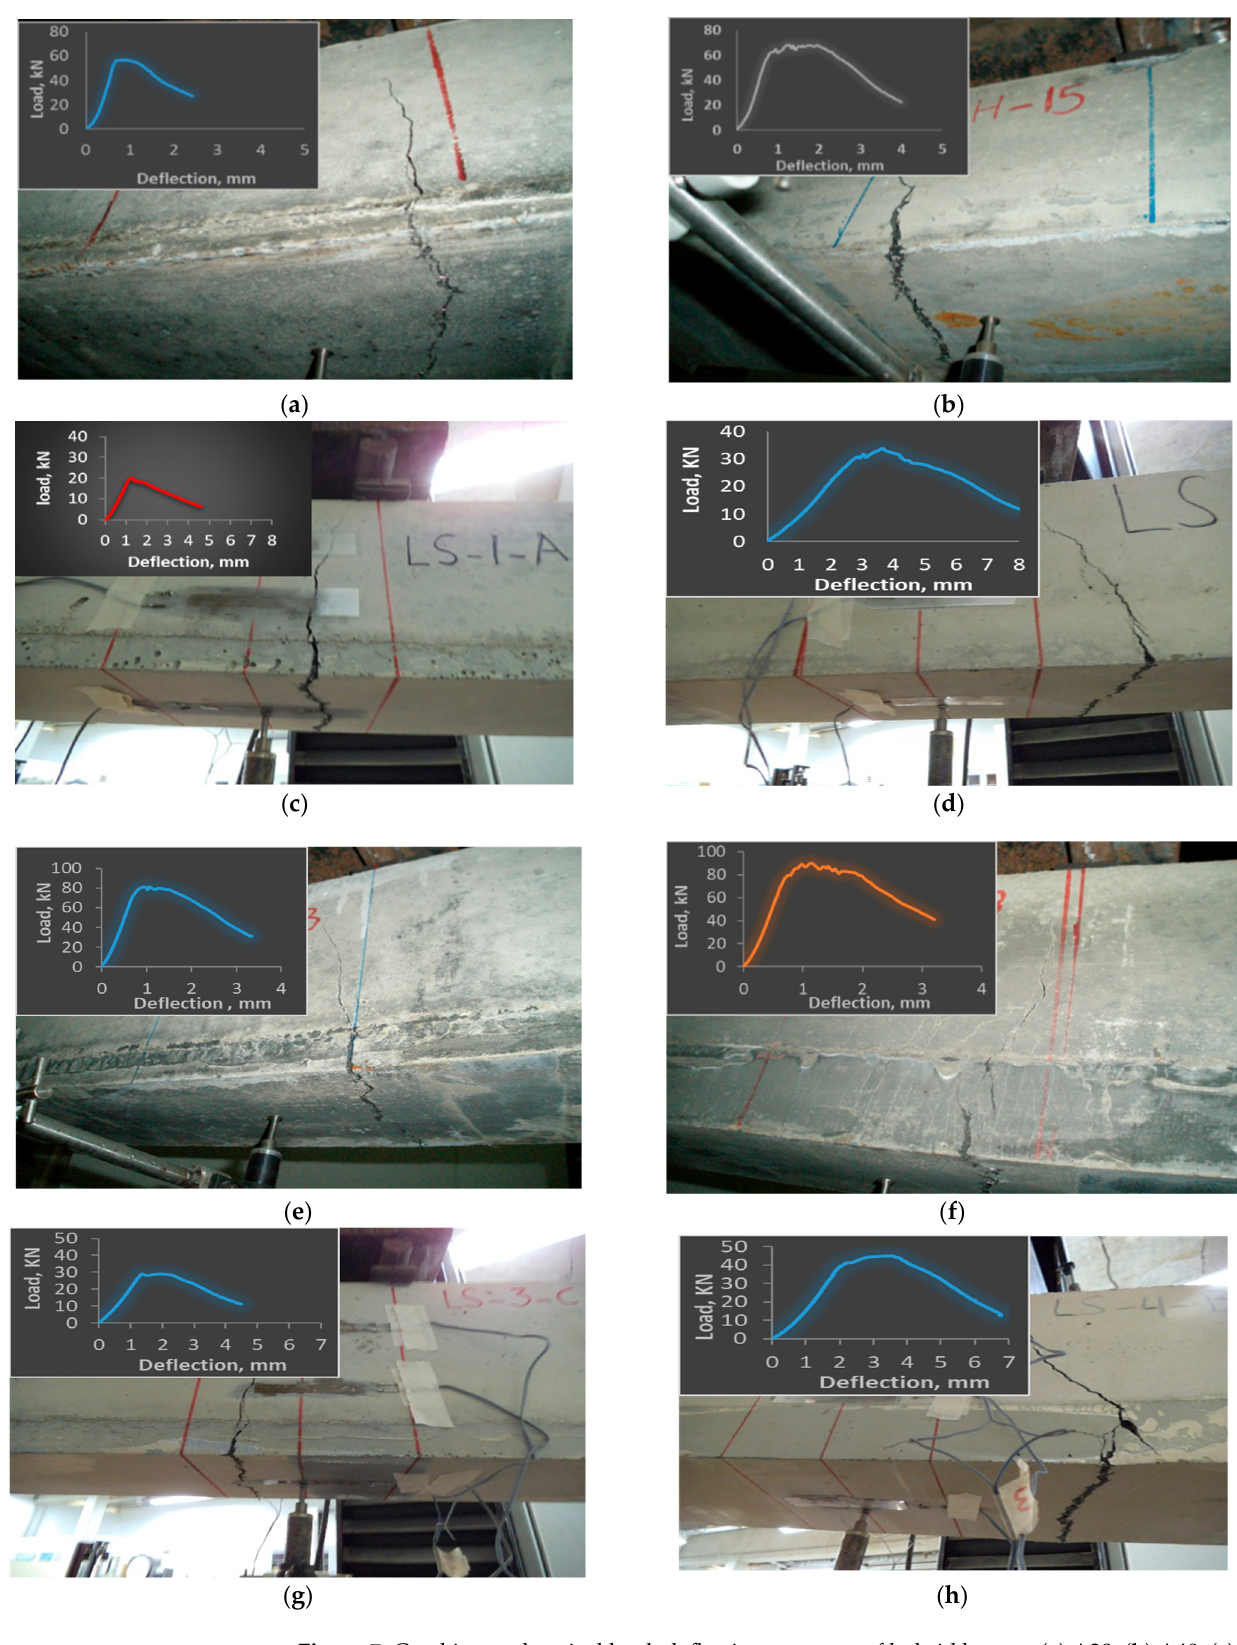
Figure 7. Cracking and typical load – deflection response of hybrid beams. ( a ) A20; ( b ) A40; ( c ) B20; ( d ) B40; ( e ) C25; ( f ) C50; ( g ) D25; ( h ) D50.